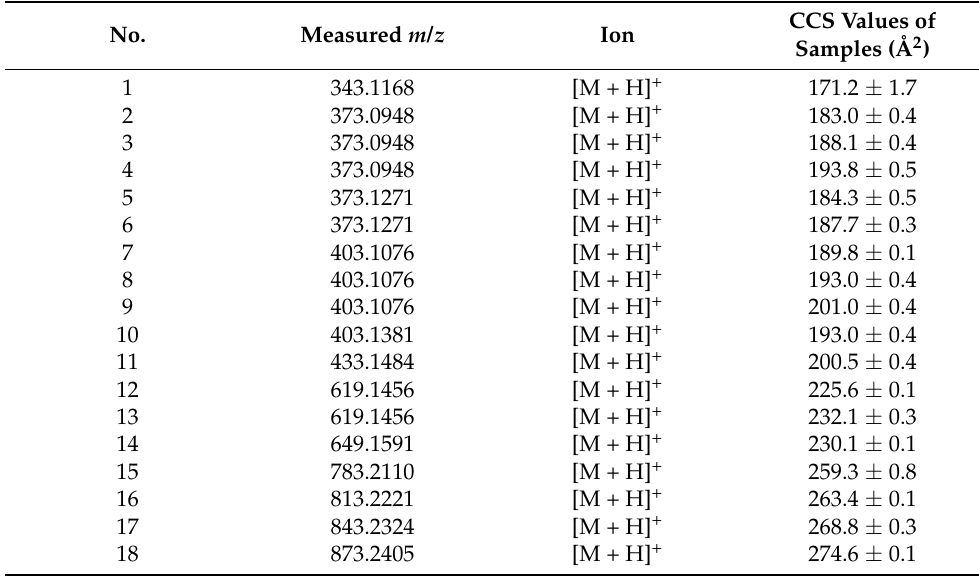
Table 2. The collision cross-section (CCS) values were measured in samples.